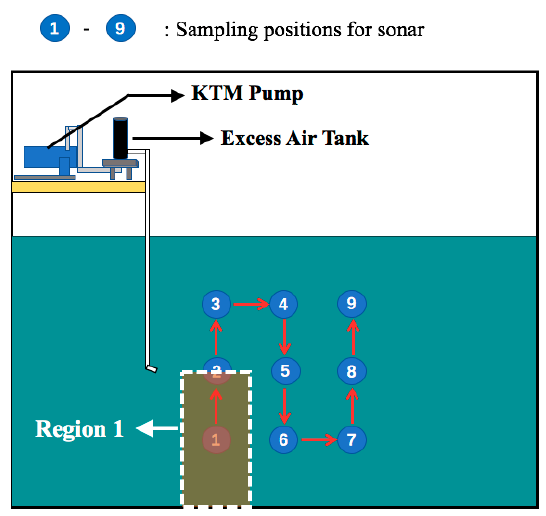
Figure 12. Sketch of plane A that intersected the release nozzle and was parallel to the sidewall of the tank which was used for measuring the residence time of bubbles.